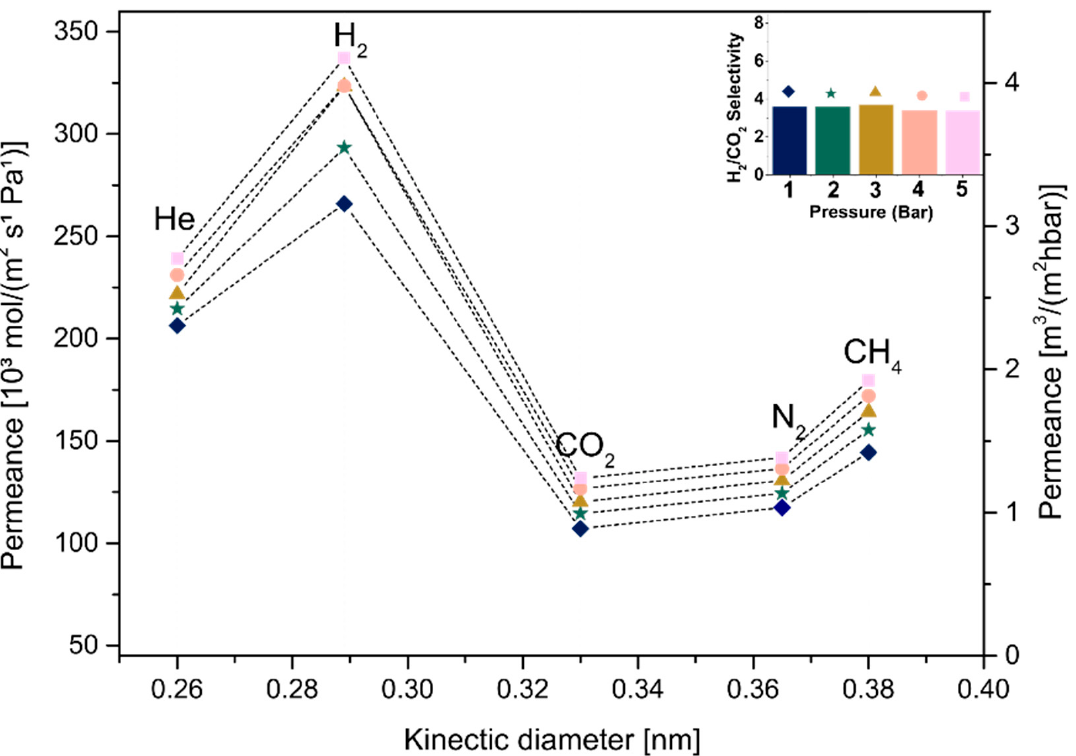
Figure 13. Single-gas permeabilities, permeances and H 2 /CO 2 selectivity under different pressures for C 2 _80.